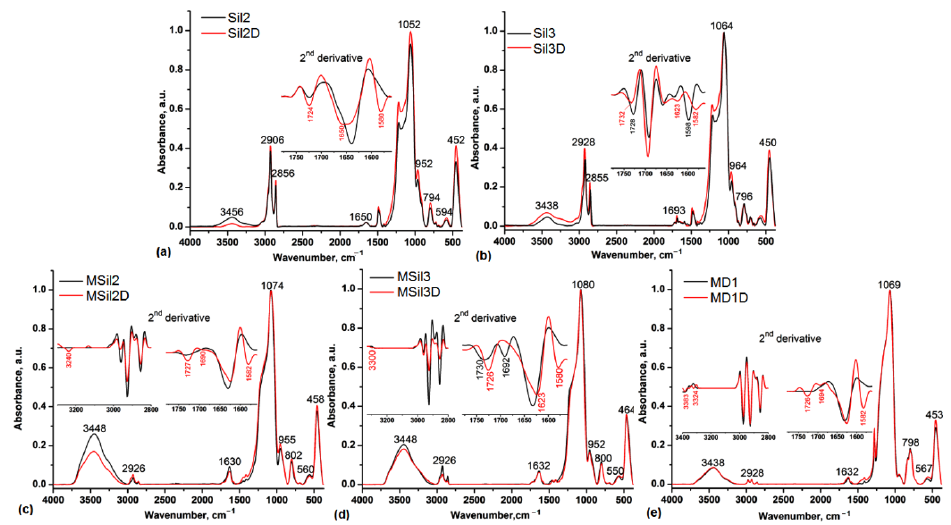
Figure 5. IR spectra of functionalized and non-functionalized silica before (black line) and after Dox encapsulation (red line): ( a )-Sil2 and Sil2D; ( b )-Sil3 and Sil3D; ( c )-MSil2 and MSil2D; ( d )-MSil3 and MSil3D; ( e )-MD1 and MD1D. Inset: second derivative of the spectra in the 3200–2800 cm − 1 and 1750–1500 cm − 1 spectral range.